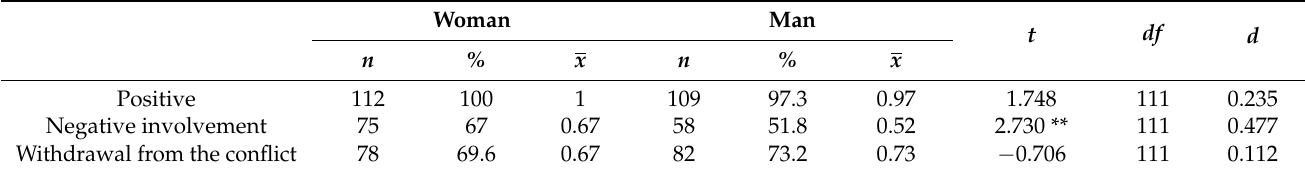
Table 6. Prevalence of the use of conflict resolution strategies (CRSI) by the violent couples according to sex.